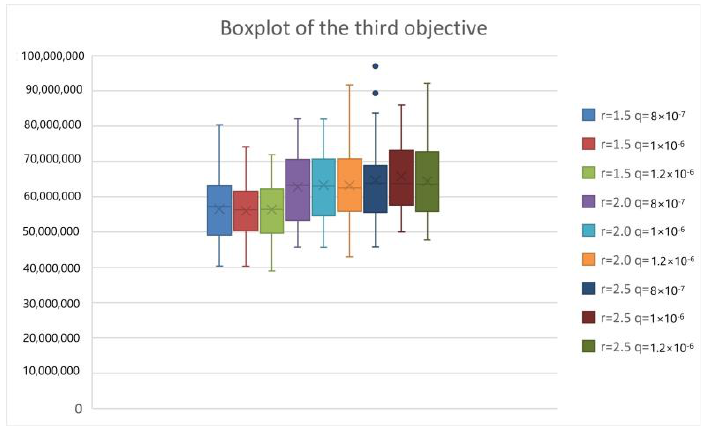
Figure 11. Boxplot chart of the overall cost.